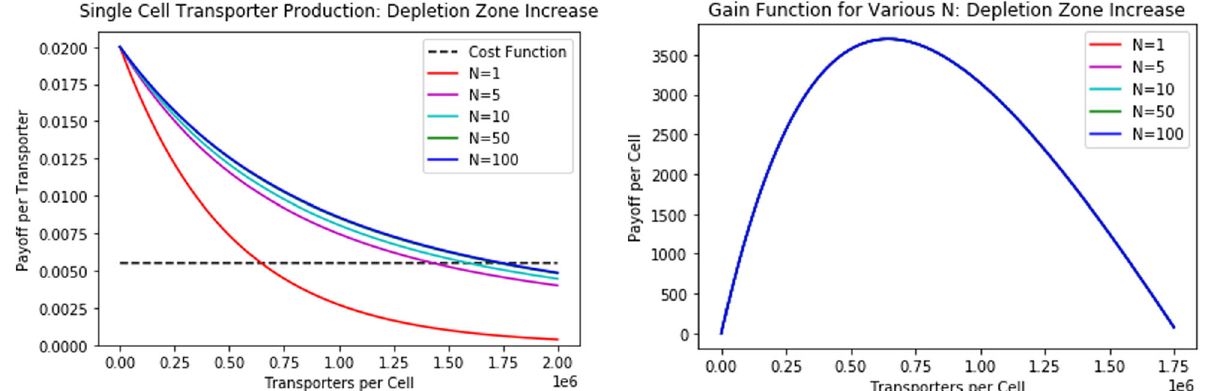
Fig. 2 How changing the depletion zone (see Fig. 12) in fl uences transporter equilibria per cell, transporter equilibria per depletion zone, and payoff curve per cell for various numbers of neighbors N . At the team-optimum (analogous to the N = 1 curves), the total number of transporters remains constant for various N . At the ESS, the number of transporters per cell increases as a function of N . Since the payoff curve per cell is the same regardless of N , the payoff to each cell depends solely on the location of the cell on the curve (determined by the ESS transporter glucose molecules through their transporters, while the cell still pays the same cost of producing and maintaining them. Medically, these drugs have been shown to result in apoptosis and decreased cancer cell proliferation 44,45 . In our model, this is